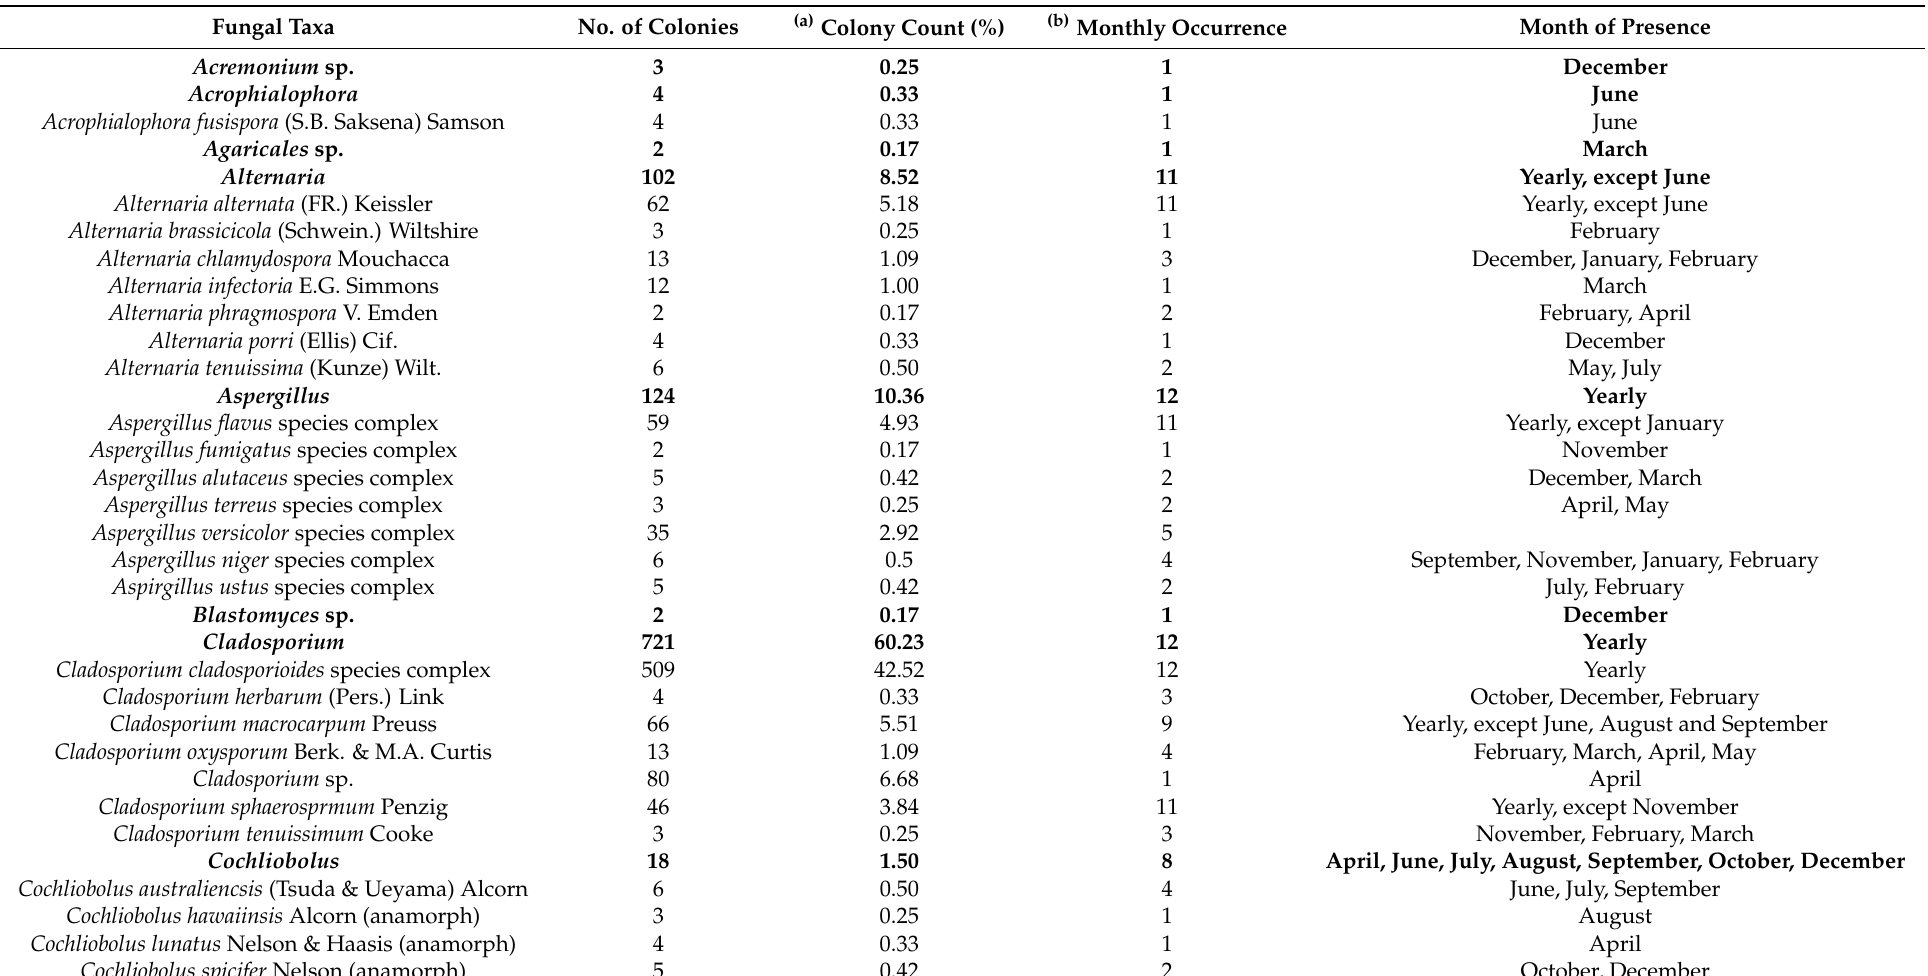
Table 1. Total colony count and occurrence of airborne fungi recovered from the air of Doha during the study period (1 April 2015 to 31 March 2016) using the gravimetric method (a total of 176 exposure samplings). Bold fonts refer to the genus and its related